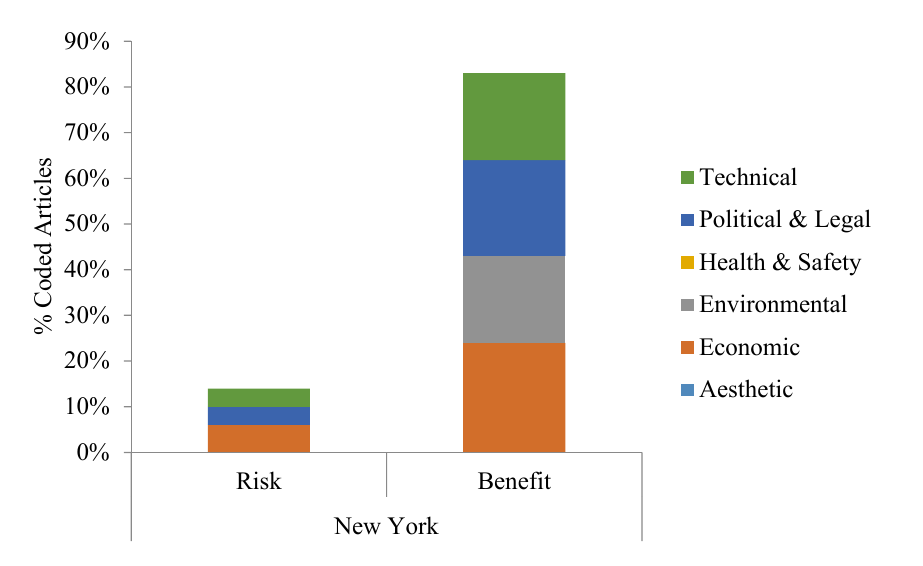
Figure 2. Media coverage of biomass function systems and their related risks and